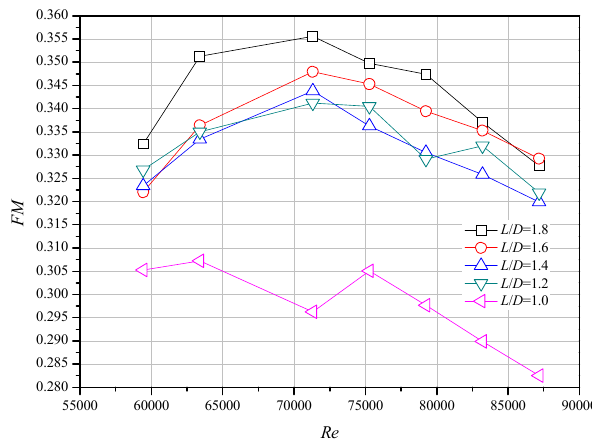
Figure 4. Variation of the figure of merit.